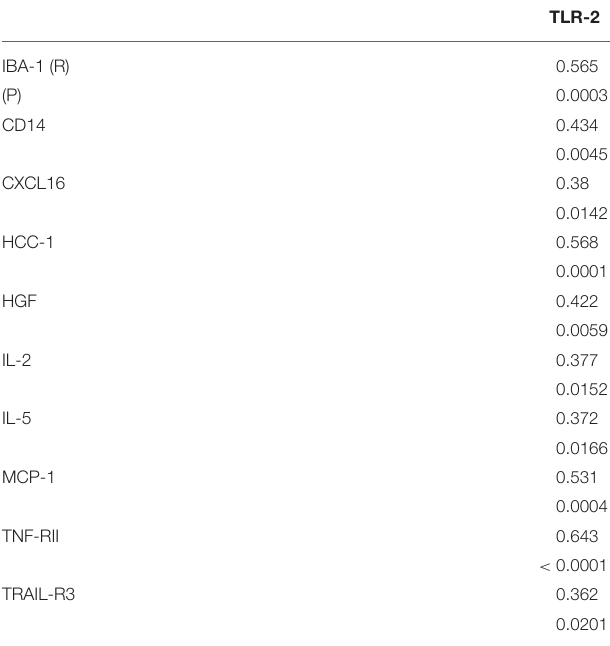
TABLE 9 | Correlations between Alzheimer’s-type pathology and protein measures. Plaques